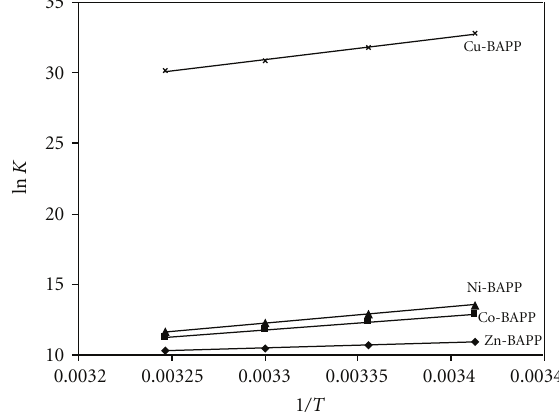
Figure 5: E ff ect of temperature on ln K of M 2+ complexes with